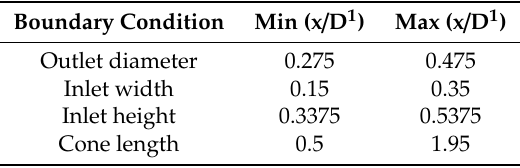
Figure 4. Design space for dataset; x1, x2, x3, and x4 is design variable of cyclone. Table 2. Range of design variable of